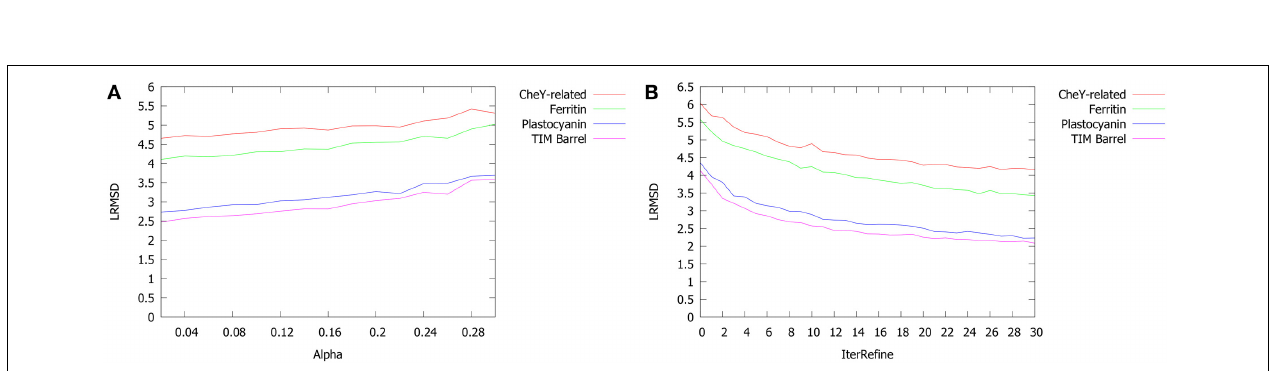
FIGURE 11 | Average LRMSD of the alignments returned by PROPOSAL on varying (A) α and (B) IterRefine. Default values: N = 6, w = 15, α = 0 . 05, IterRefine = 10.